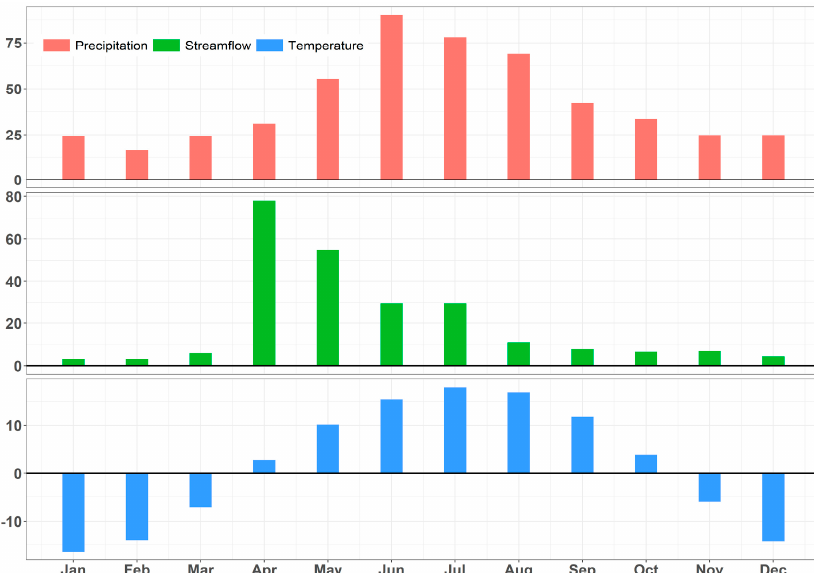
Figure 2. Hydro-climatic data of the Upper Assiniboine River basin at Shellmouth reservoir: mean monthly precipitation (mm), mean monthly streamflow (m 3 / s), and mean monthly average temperature (°C) over 1988–2017 time period.